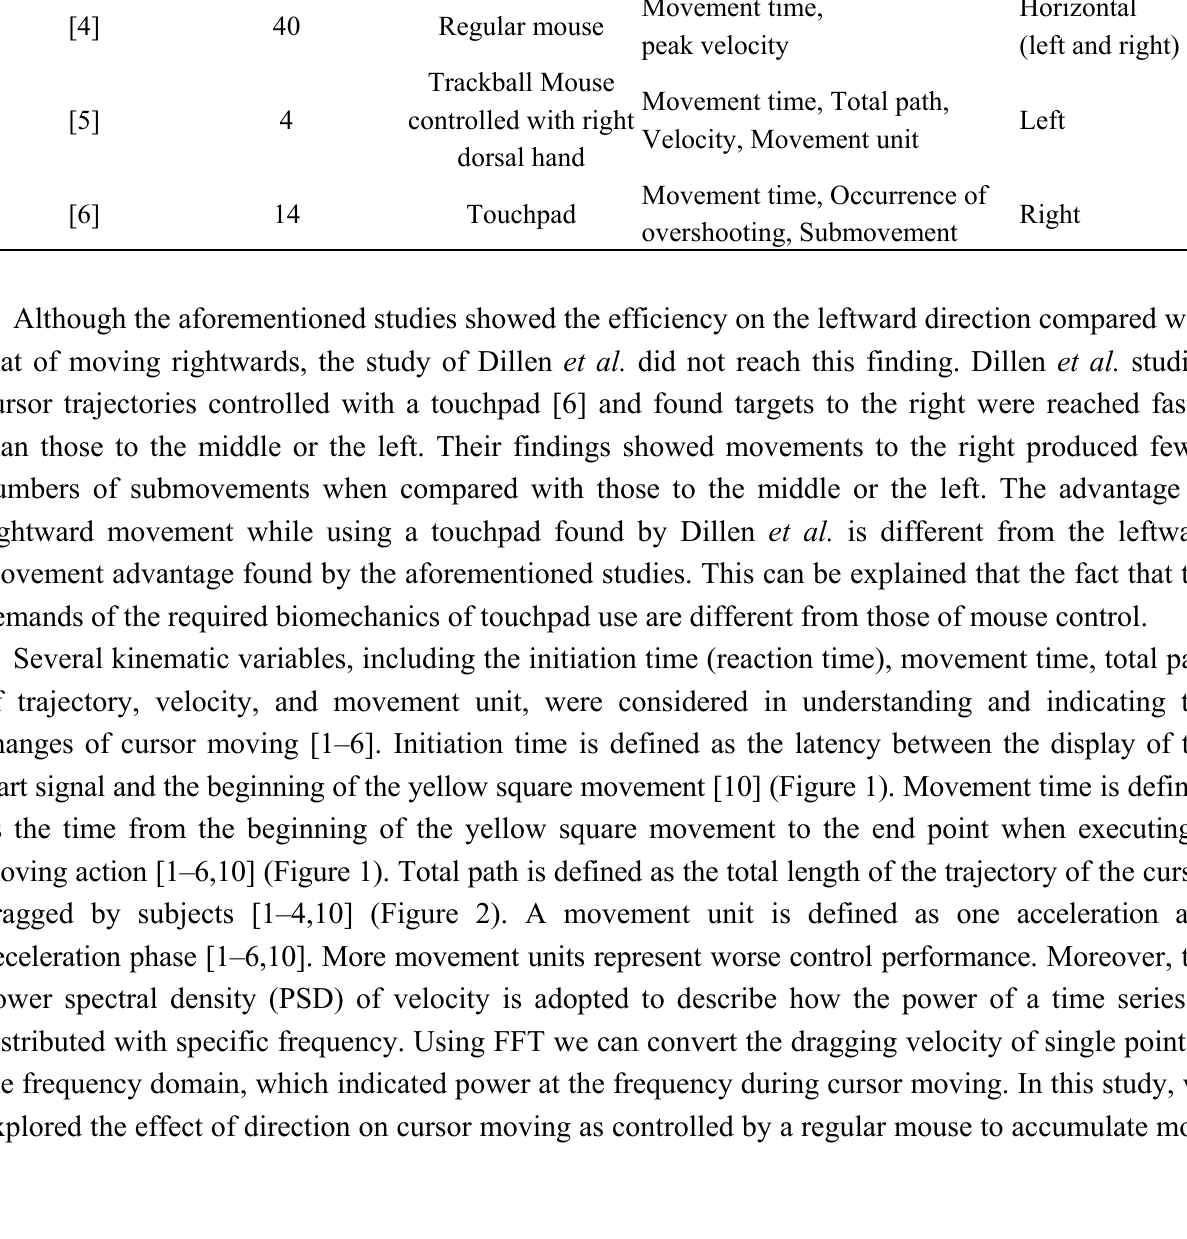
Table 1. The effect of cursor moving direction on kinematics based on the literature review. Reference